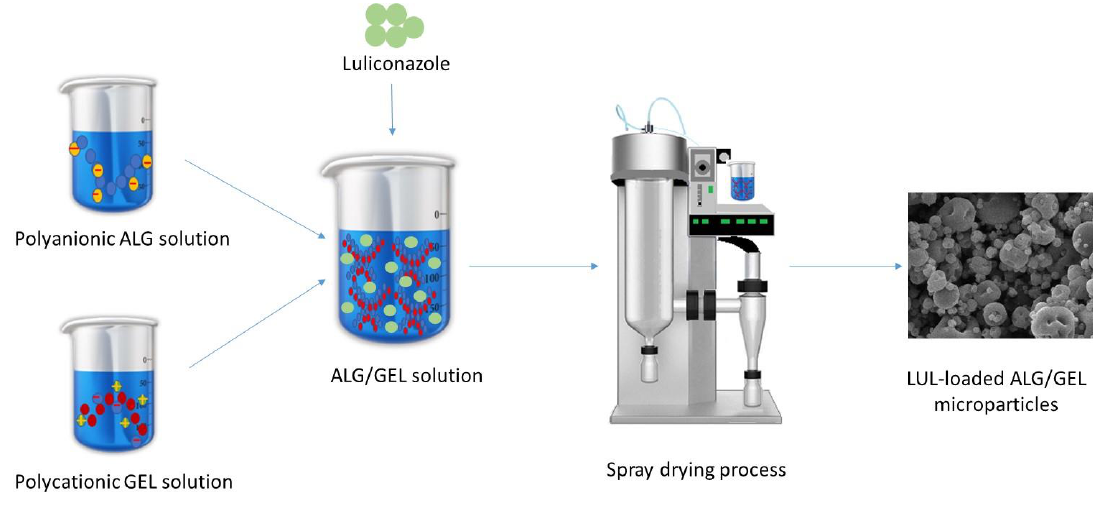
Figure 1. Scheme for LUL-loaded ALG/GEL microparticles